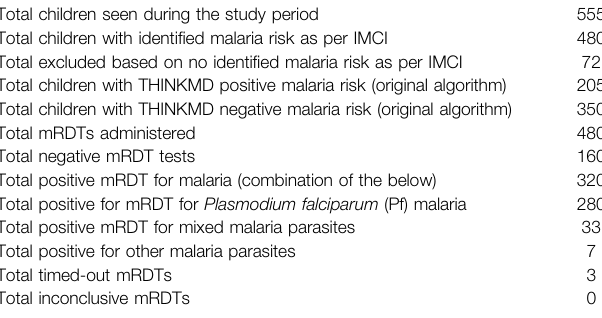
TABLE 1 | Summary of clinical malaria assessments and malaria RDT (mRDT)